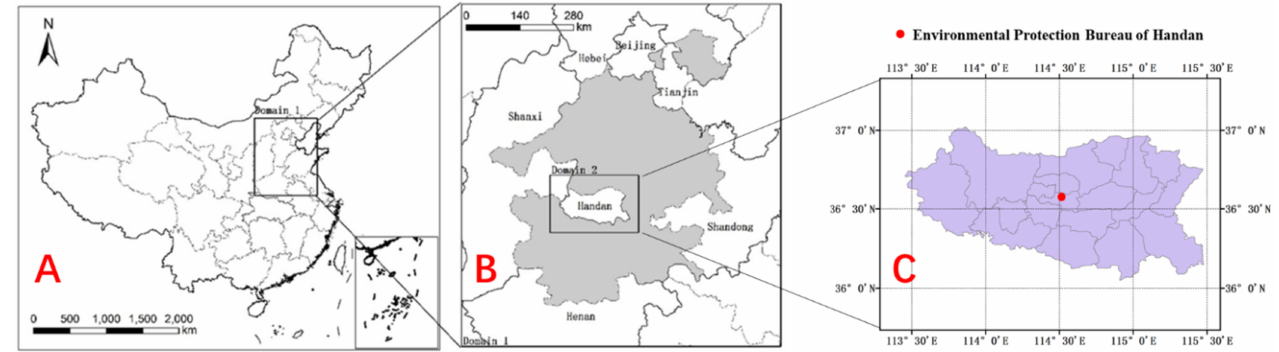
Figure 1. Location of the sampling sites ( c ) and WRF-Chem modeling domain setting ( a , b ). The grey areas are the other “2 + 26” cities in Beijing-Tianjin-Hebei region and surrounding